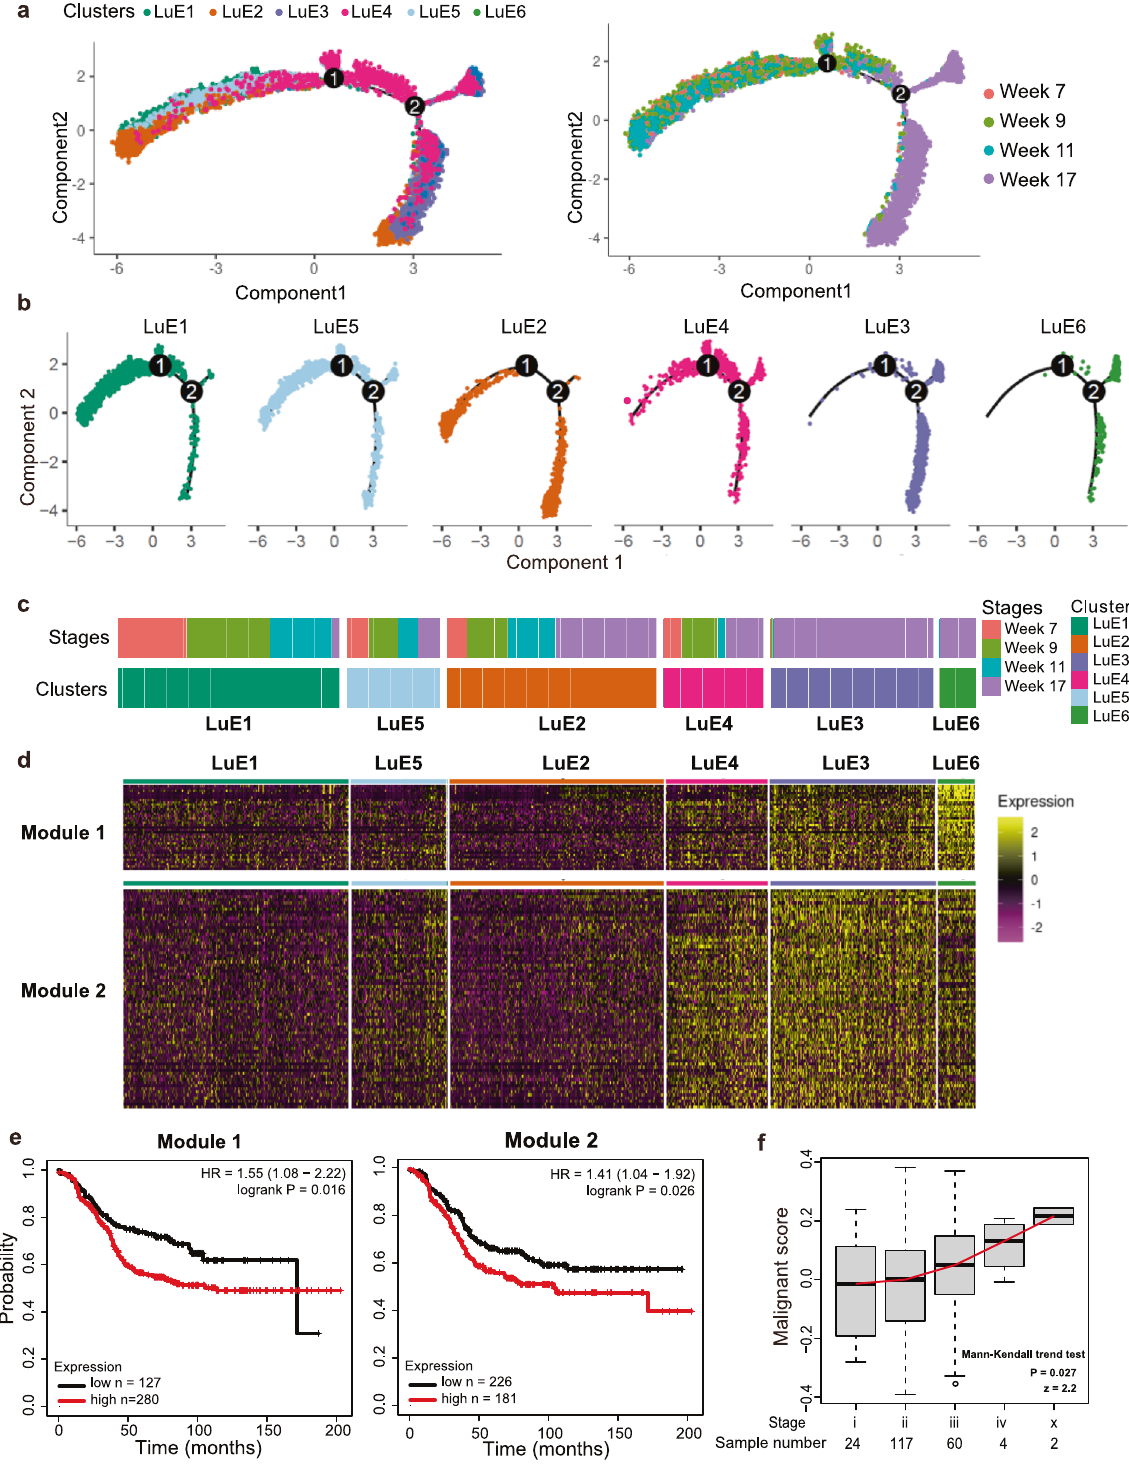
Fig. 3 A continuous change of speci fi c gene signature in ER low luminal cells was correlated with the tumor progression and clinical outcome. a Pseudo-time trajectory analysis of the six sub-clusters of luminal epithelial cells annotated by clusters (left) and tumor progression stages (right). b Pseudo-time trajectory of cells in each luminal epithelial cell cluster. c The heatmap showed the sample composition of each cluster, indicating that the composition of week 17 was gradually increased along cluster LuE1, LuE5, LuE2, LuE4, LuE3, and LuE6. d Heatmap of expression pro fi le of signature genes in indicated modules identi fi ed by WGCNA (Weighted Gene Co-expression Network Analysis). A summary list of genes associated with corresponding WGCNA module were shown in supplementary Table 3. e The Kaplan – Meier relapse free survival curves of patients were grouped by the gene signatures in WGCNA modules. The left corresponded to the module 1 and the right corresponded to the module 2. f Boxplot depicted the distribution of malignant score derived from luminal B patient samples in TCGA. Mann- Kendall trend test was performed using the median value of each stage by “ trend ” package in